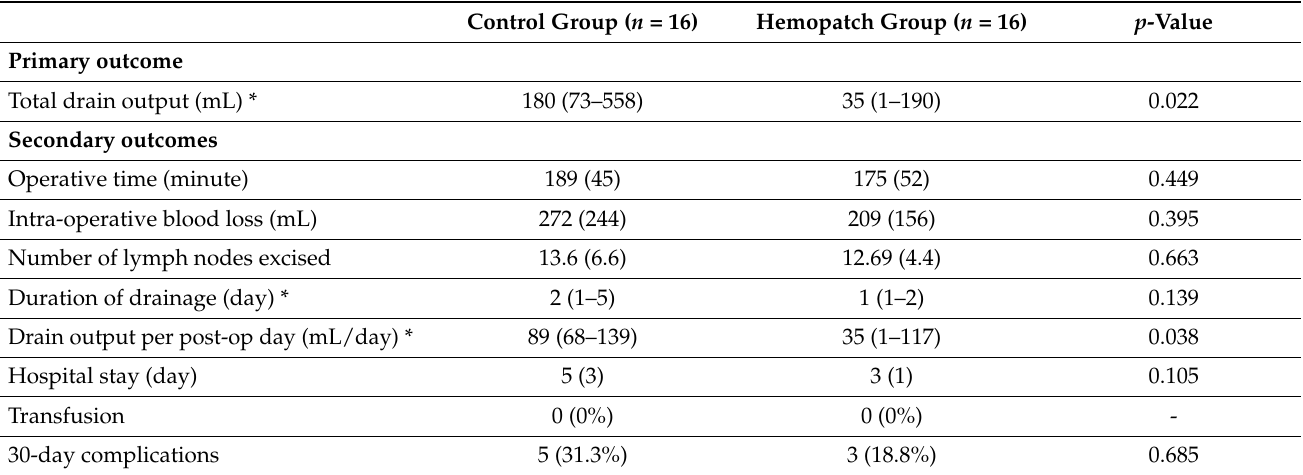
Table 2. Primary and secondary outcomes.